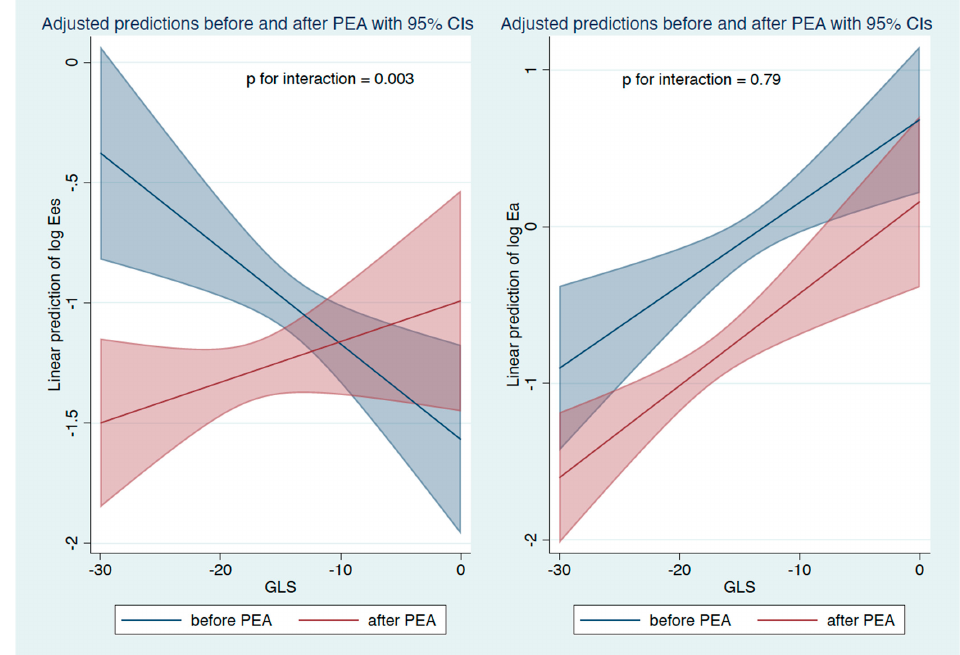
Figure 4. Linear relationship between GLS and contractility Ees (end-systolic elastance of the RV) and its interaction with PEA—( left panel ). Linear relationship between GLS and afterload Ea (elastance of the pulmonary artery) and its interaction with PEA—( right panel ).